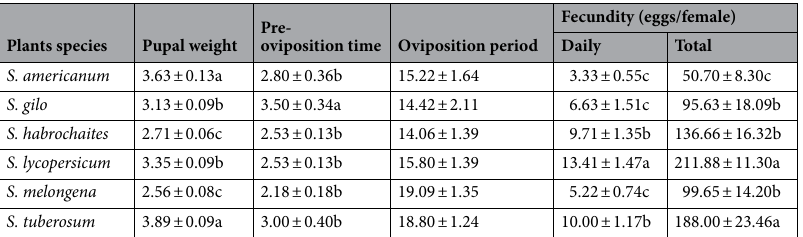
Table 2. Tuta absoluta mean (± SE) pupal weight (mg), pre-oviposition time (days), oviposition period (days) and fecundity (daily and total) when offered different host plant species. The values followed by different letters were significantly different according to the Scott Knott test ( p < 0.05) when comparing different plant species. The total of females tested for the study of T. absoluta fecundity were 10 for S. americanum , 11 for S. melongena and S. gilo , and 15 for S. habrochaites , S. lycopersicum and S. tuberosum. Data for C. annuum , C. chinense and S. aculeatissinum were not included in the table because of the high mortality rate of larvae, making it impossible to continue the life table study of the insects placed on these host plants.